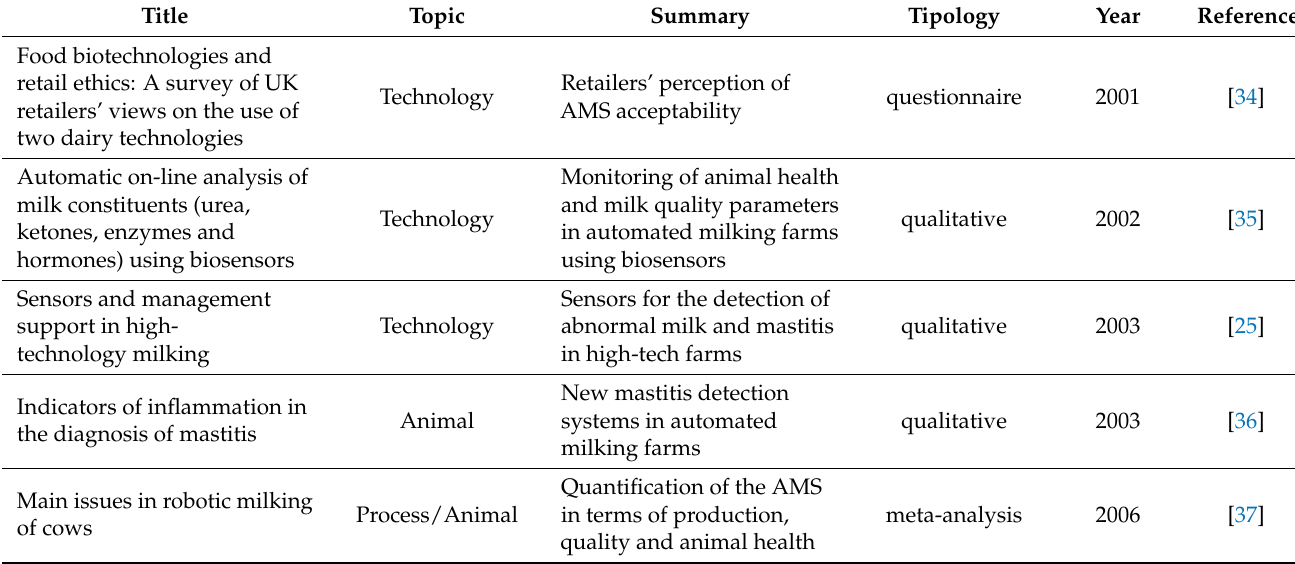
Table 2. Overview of the reviews yielded from 2000 to 2019 in the automatic milking systems (AMS) sector.